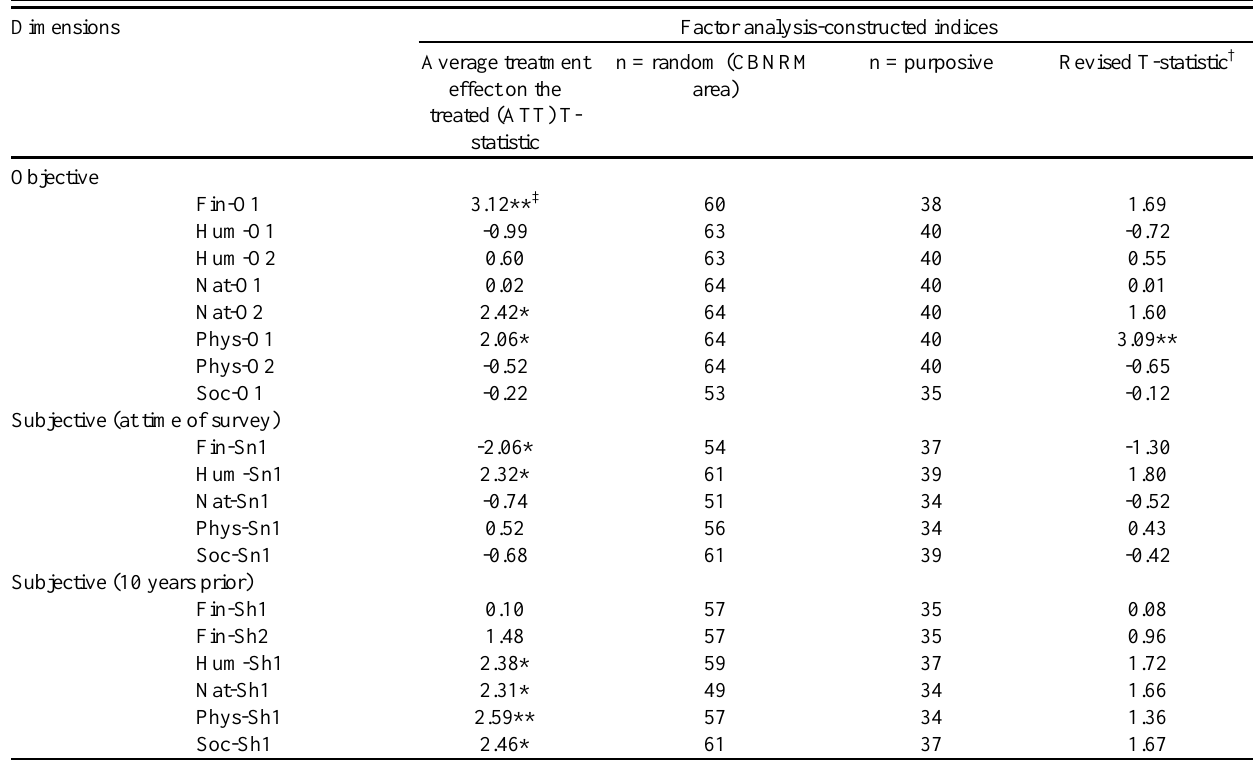
Table 6 . Kwandu Conservancy: impact of project activities on poverty dimensions, purposive and random group (within community based natural resource management [CBNRM] area).